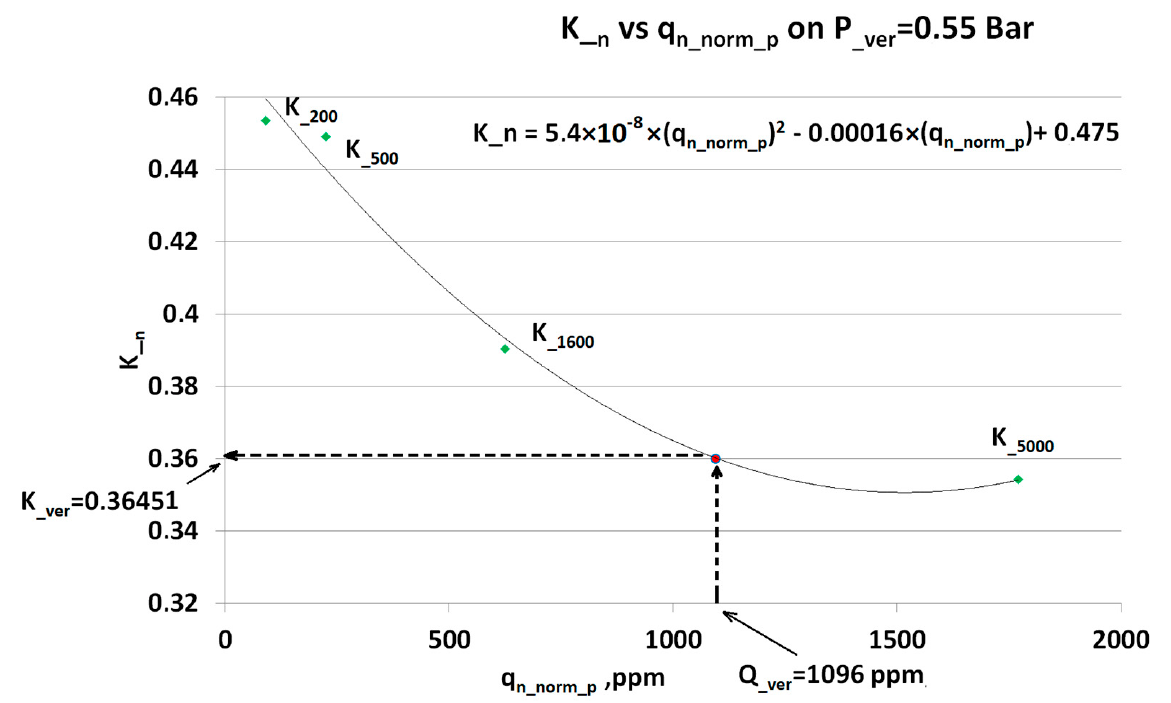
Figure 11. The dependence K _n vs. q n_norm_p contains a set of all possible compensation factor within a calibrated range at the specific pressure (here P _ver = 0.55 Bar) where q meas was obtained. The K _n dependence-equation gives the value of the compensation (here K _ver ) matching the respective reported q meas (here Q _ver ). Table 5 summarizes all calculated parameters for both verification concentrations from Table 2. Table 5. Calculated parameters for selected verification points.